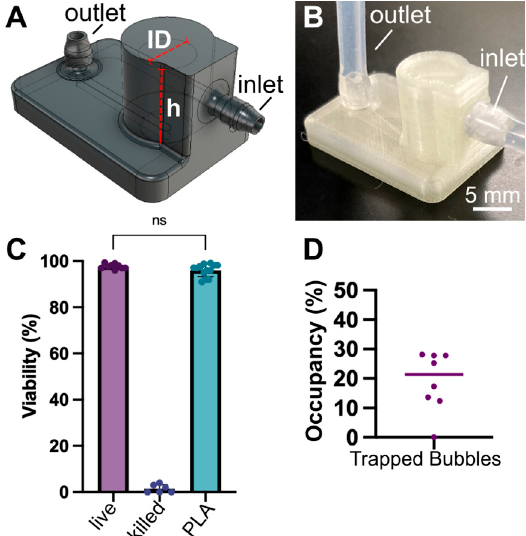
Figure 3. 3D printed degassers provided prolonged bubble removal and were cytocompatible. ( A ) Design schematic of degasser intended for FDM fabrication. ID = 5 mm, h = 7 mm, barbs for 1/16 in ID tubing at inlet and outlet. ( B ) Photo of FDM printed bubble trap with tubing connected. ( C ) Quantification of viability of human T cells cultured in conditioned media that was collected as effluent from degassers, compared to live and ethanol-killed plate controls. Viability was defined as percent of cells positive for calcein. One-way ANOVA, ns ( p = 0.1883). ( D ) The percent of the degasser chamber occupied by bubbles after 14 days of media perfusion at 37 °C. All data points are at less than 30% of total available capacity, with a median of 21.3% capacity. Each data point represents one bubble trap, and the line represents the median.